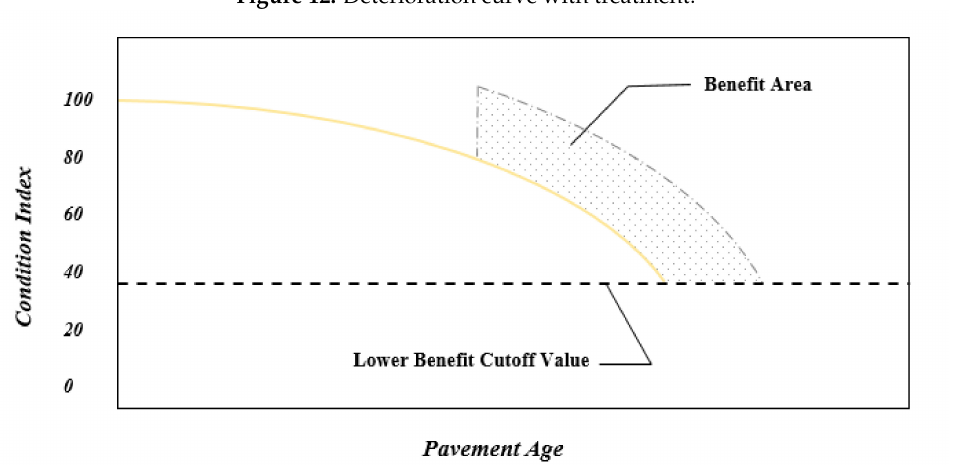
Figure 12. Deterioration curve with treatment.